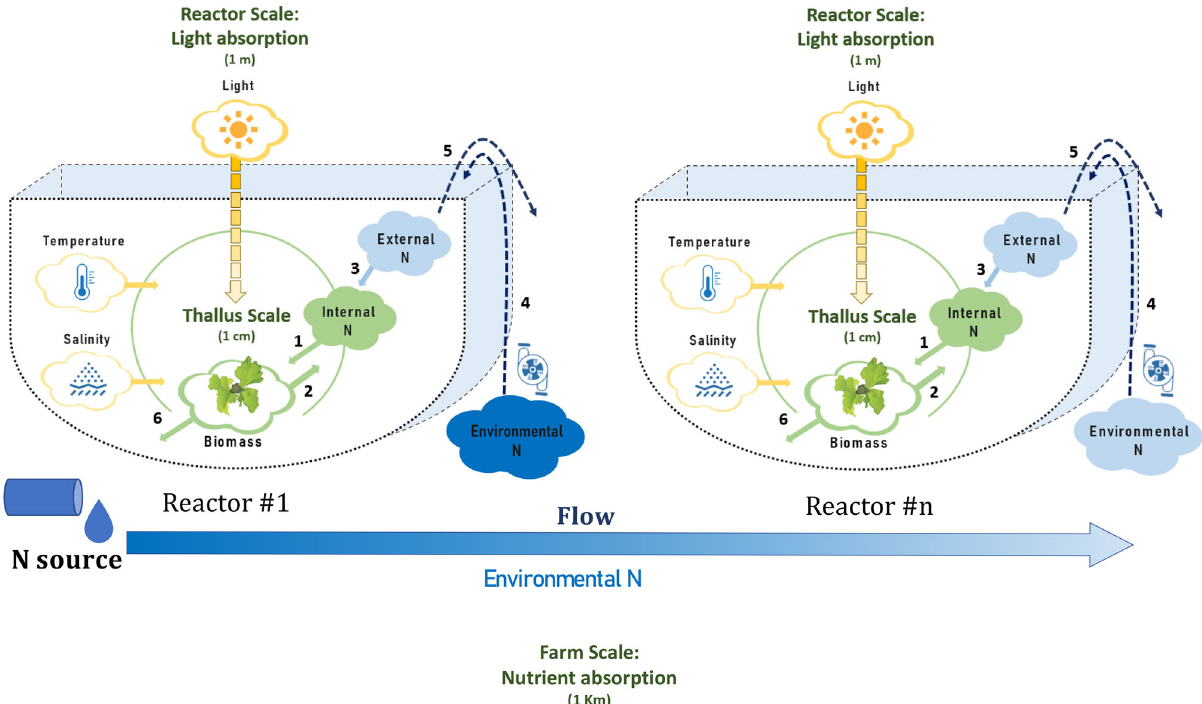
Fig. 1 A schematic description of the multi-scale model. The thallus scale (1 cm, green circle) is composed of a simple metabolic model of Ulva , in which the production of new biomass ( Ulva icon) is affected by internal nitrogen (N, full green cloud) and by constraining environmental conditions, including light intensity, salinity and temperature (yellow clouds). The reactor scale (1 m, U shape pictures) adds light extinction effects (yellow graduated arrow), the concentration of external N in the reactor and the concentration of environmental N outside the reactor (dark/light blue clouds, depending on N concentration). The farm-scale (1 km, row of reactors starting at Reactor #1 and counting downstream to Reactor #n) adds the nutrient reduction caused by absorption in reactors along with the fl ow (Blue graduated arrow). Green and blue clouds represent the model state variables. Numbers represent the following processes: 1. Biomass growth; 2. Dilution of internal N by growth; 3. N uptake; 4-5. Water exchange by airlift pumping and over fl ow, and 6. Biomass